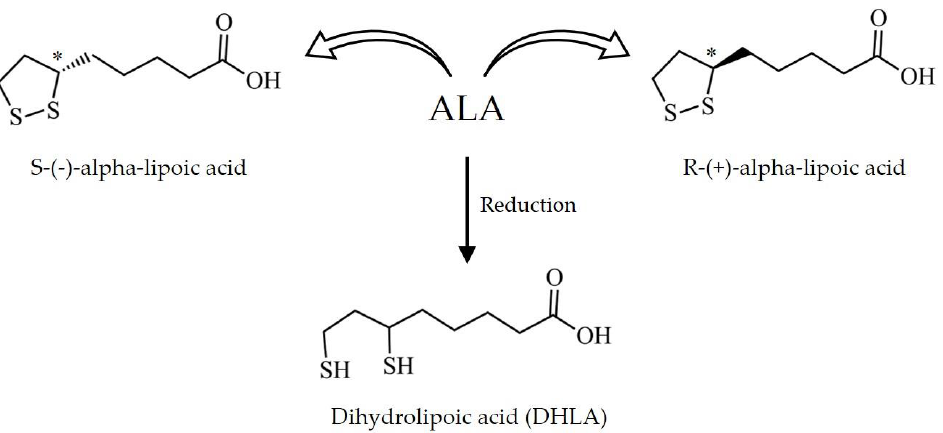
Figure 1. Chemical structure of alpha-lipoic acid (ALA). ALA exists as the levorotatory isomer S-(−)-ALA and the dextrorotatory isomer R-(+)-ALA. Upon reduction, ALA generates dihydrolipoic acid (DHLA). * Carbon chiral center.